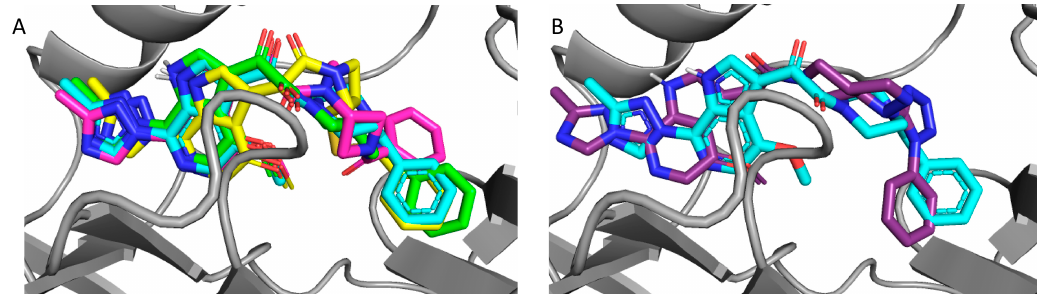
Figure 4. Overlay of docked compounds on the cocrystal of BMS-626529; ( A ) BMS-626529 (cyan), compound 8 ( SC11 , green), compound 13 ( SC16 , yellow), and compound 18 ( SC18 , magenta). ( B ) BMS-626529 (cyan) and compound 23 ( SC39 , purple).